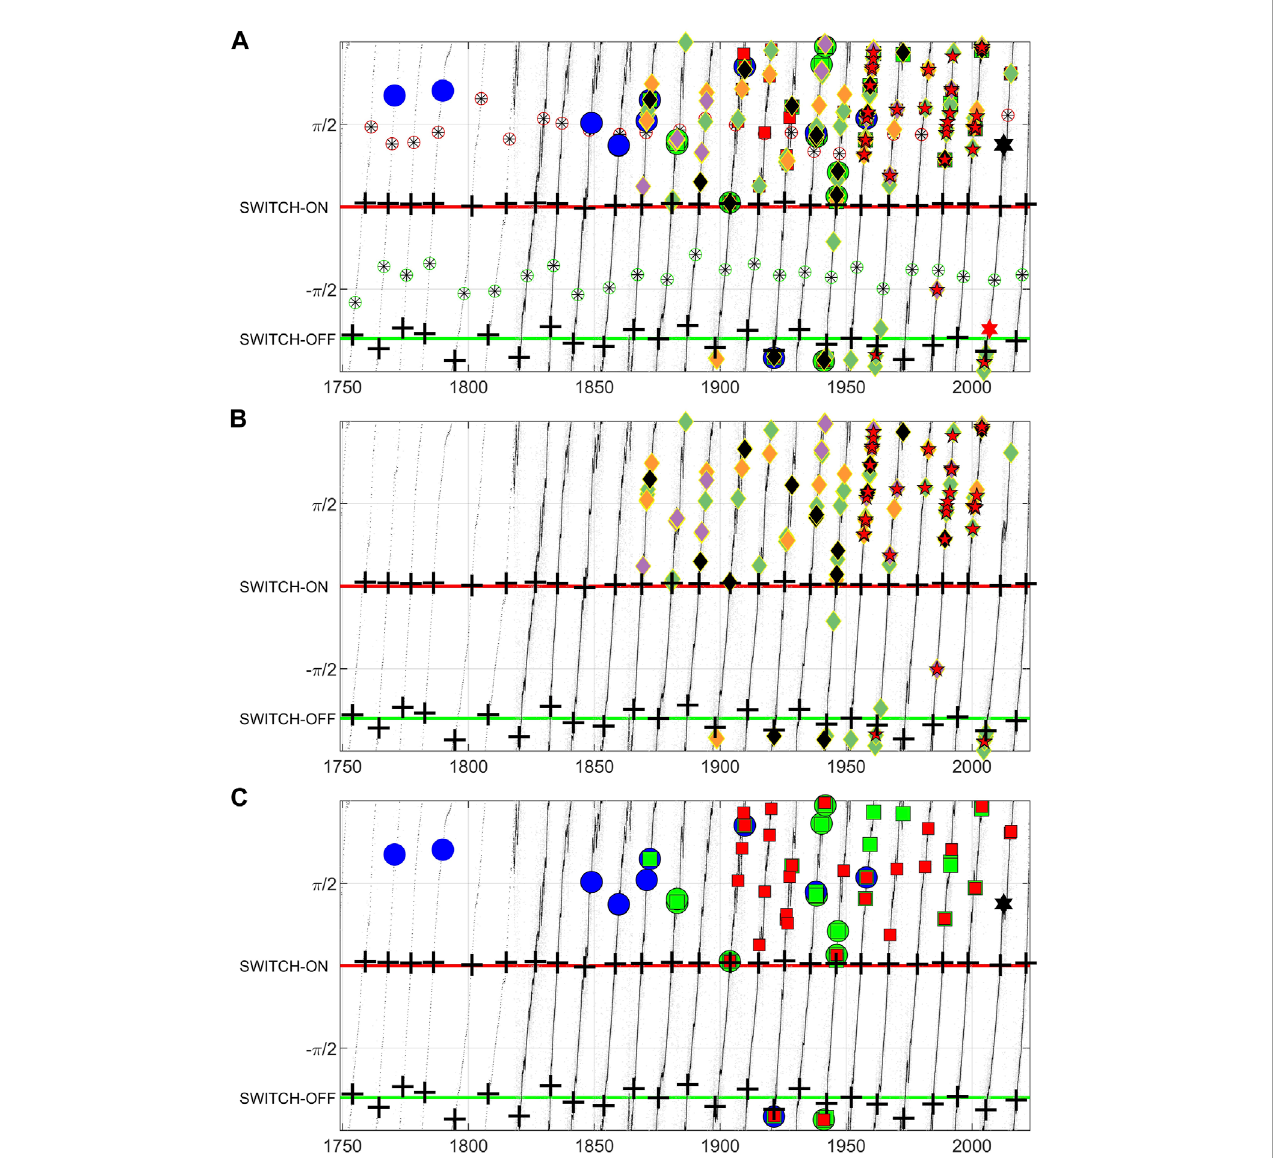
FIGURE 5 Charting solar cycle dependence of space weather impacts. The analytic phase of the monthly, and after 1818, daily SSN is plotted versus time. In all panels horizontal lines for phase − 4 π / 5 (green) and zero (red) indicate the switch-off (pre-terminators) and switch-on (terminators) of activity. The black crosses are estimates of the switch-on/off times obtained directly from the monthly SSN as in Figure 3 . (A) : Solar maxima and minima are plotted as red and green circled black asterisks respectively. Extreme space weather events are plotted on the chart. These are as follows. (A, B) : Red 5-pointed stars plot days when Dst <− 250 nT . Diamonds plot days when the aa index has exceeded 300, 400, 500, and 600 nT (green, orange, cyan, and black). (A, C) : Blue and green circles from Table 1 and Table 2 of Knipp et al. (2021). Red 6-pointed star: a moderate December 2006 event discussed by Knipp et al. (2021). Green squares: Tables I, III, IV, and VII of Cliver and Svalgaard (2004). Red squares: Table 1 of Love (2021). Black 6-pointed star: July 2012 Carrington class event that missed the Earth Baker et al. (2013).